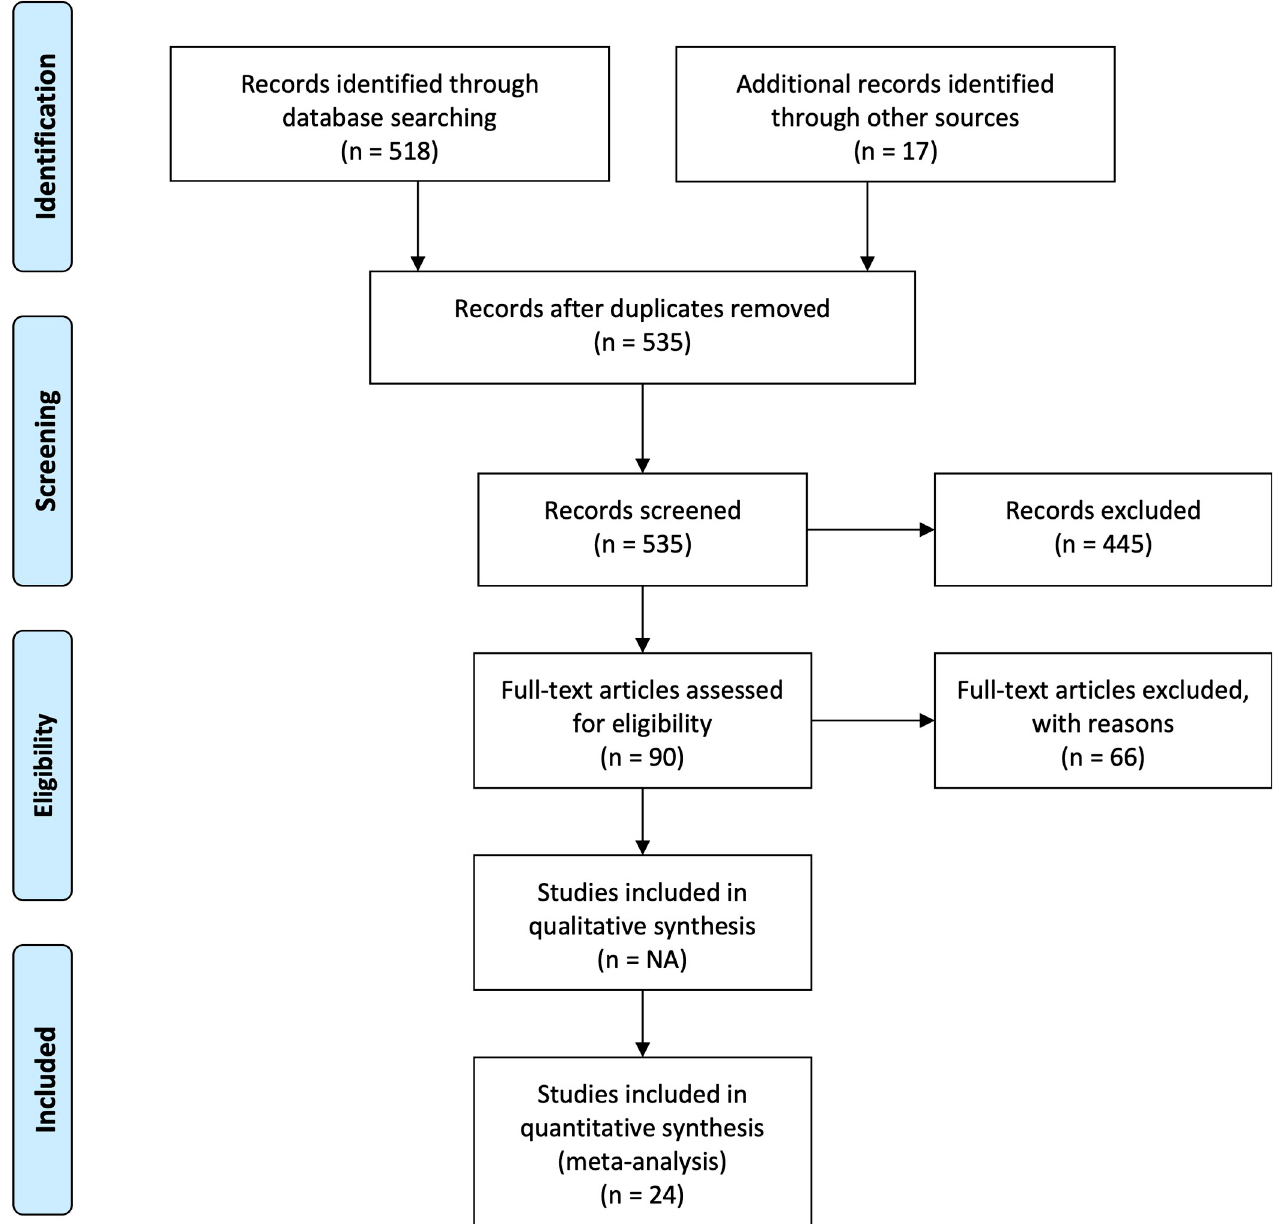
Fig 1. PRISMA diagram. Specific to this meta-analysis, from Moher et al. [37] .